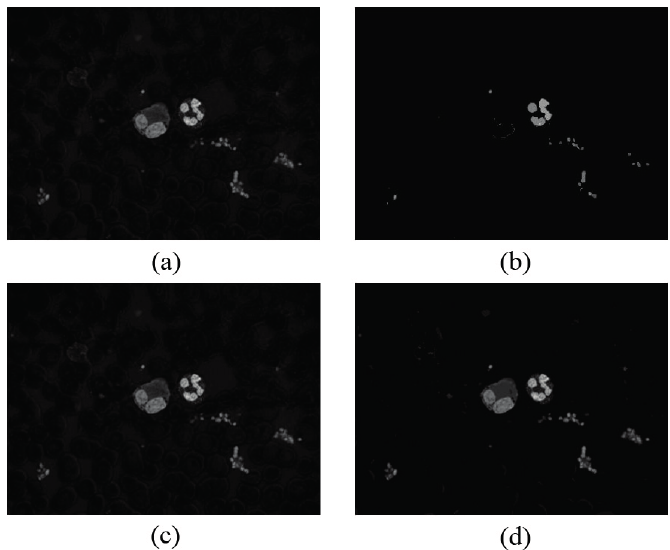
h , h ) = (1,13); s r h , h ) = (3,3). s r